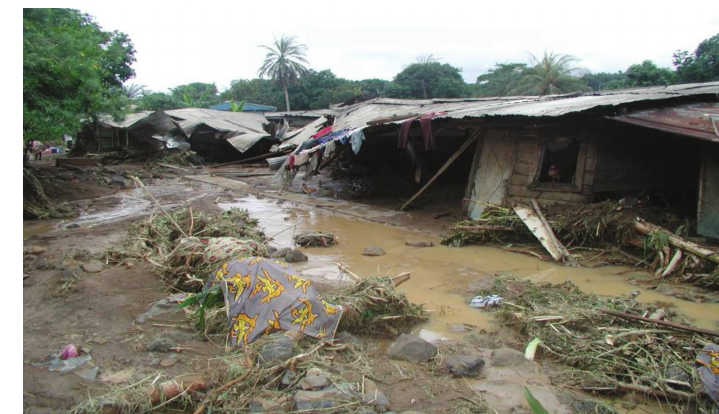
Source: Nsoyunic Lawrence, Date